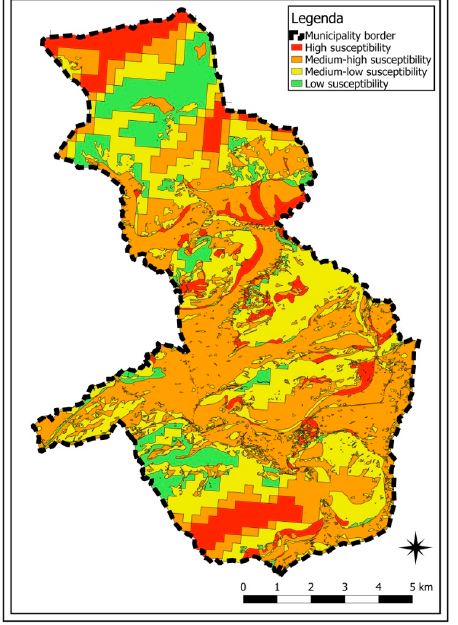
Figure 21. Combined extreme event susceptibility map obtained by averaging the two susceptibilities analysed.